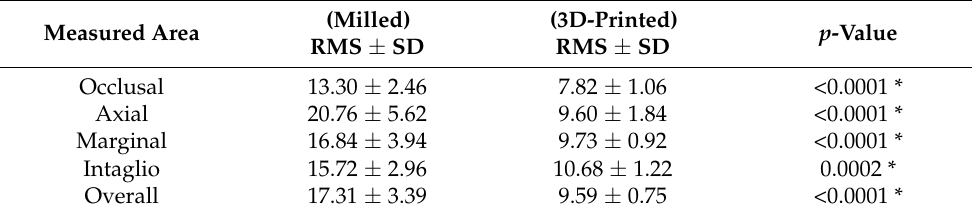
Table 4. Precision means RMS ± SD ( µ m), and significance values between the milled and 3D-printed crowns. (Milled) Measured Area